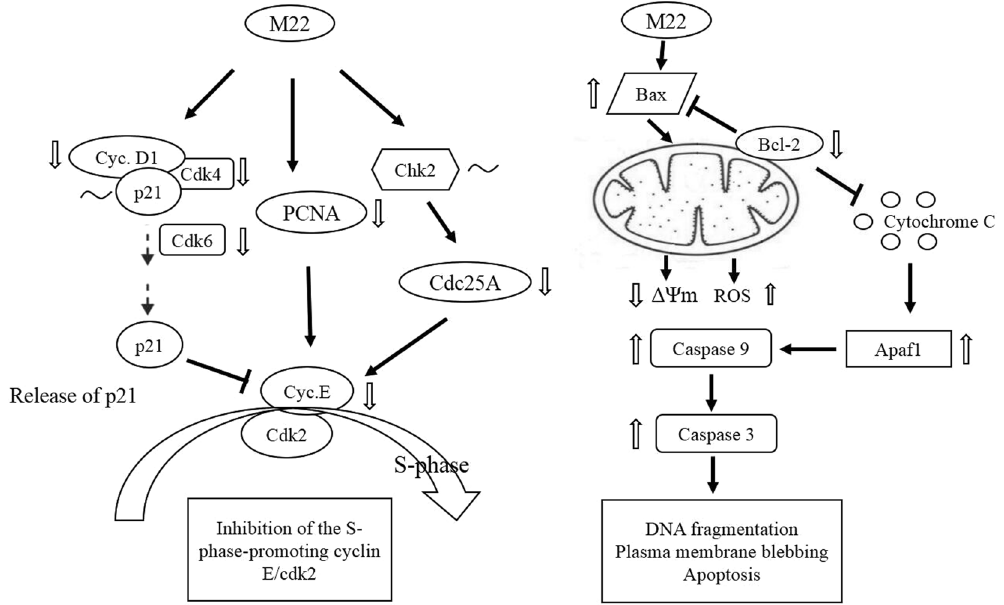
Figure 7. Proposed mechanism of action of M22 in the cell growth regulation of A549 cells. ΔΨ m, change in mitochondrial transmembrane potential; ↑ , upregulated expression; ↓ , downregulated expression; ~, no change in